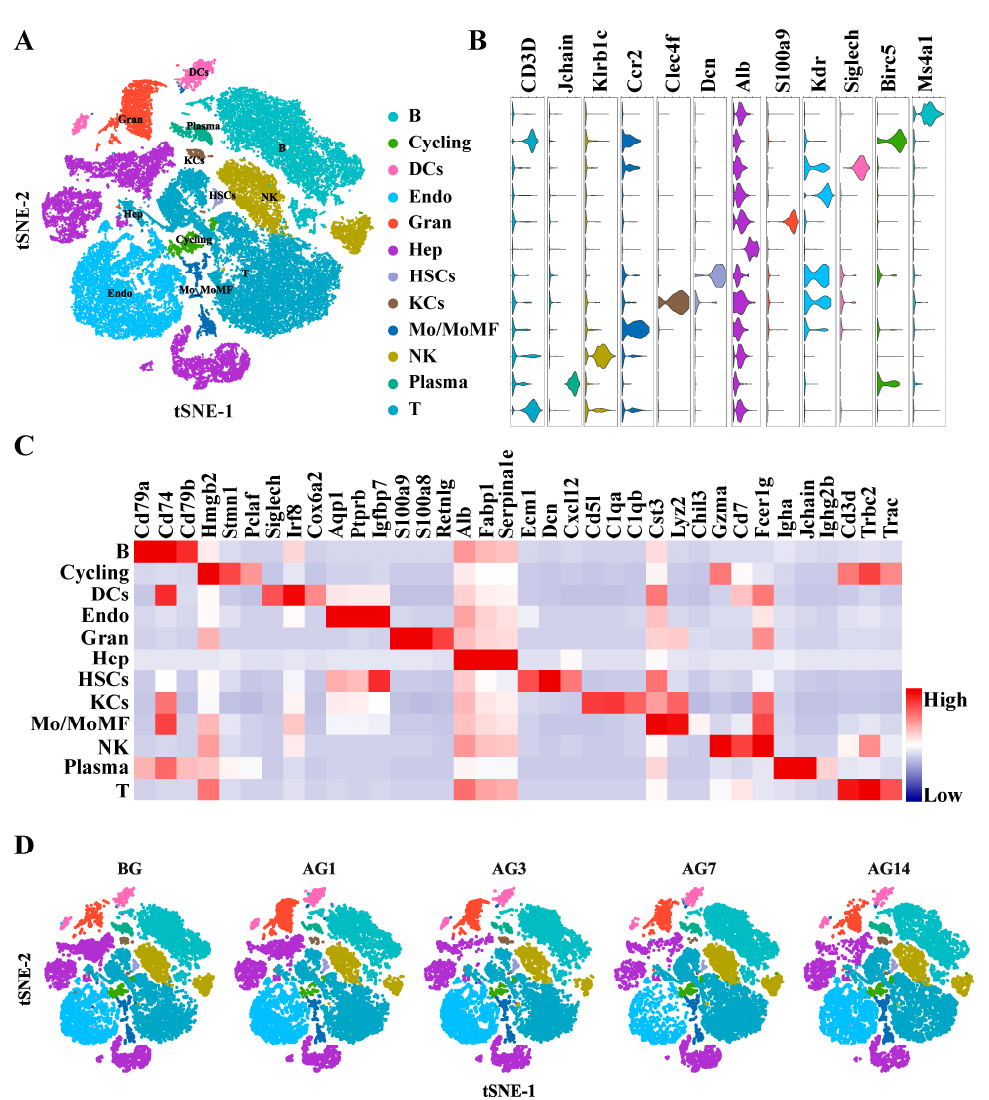
Figure 2. Clustering and annotation of liver transcriptome in mice with alcoholic liver injury. ( A ) A total of 50,274 mouse liver single cell transcriptome and cell-type annotation of each subpopulation based on the differential expression of liver cell type-specific genes. ( B ) Expression of representative enriched genes for each cell type. Gene expression violin plots are shown in log-scale UMI. Colors correspond to cell types. ( C ) Heatmap displaying the expression level of established liver cell type- specific top 3 markers in each cell type. ( D ) The t-SNE plot shows the different distribution of 12 clusters in BG, AG2, AG3, AG7 and AG14 mice.